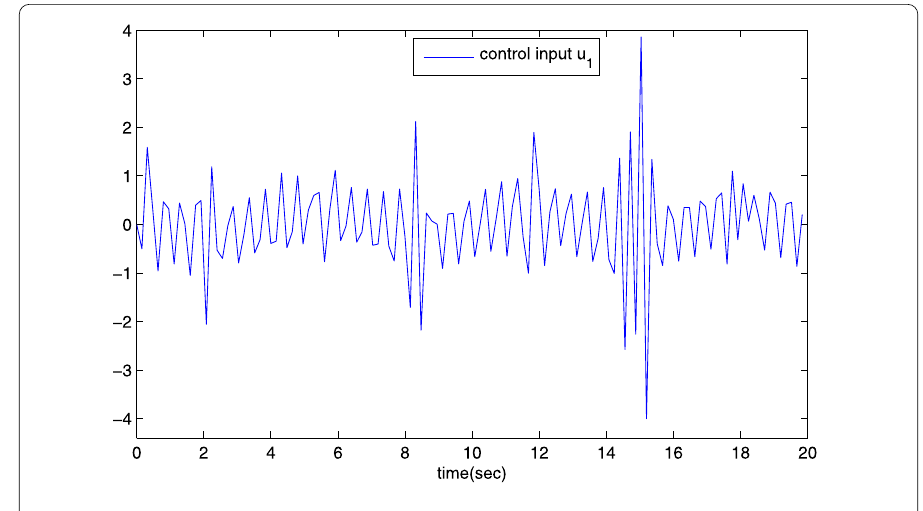
Figure 3 Responses control input u 1 of example